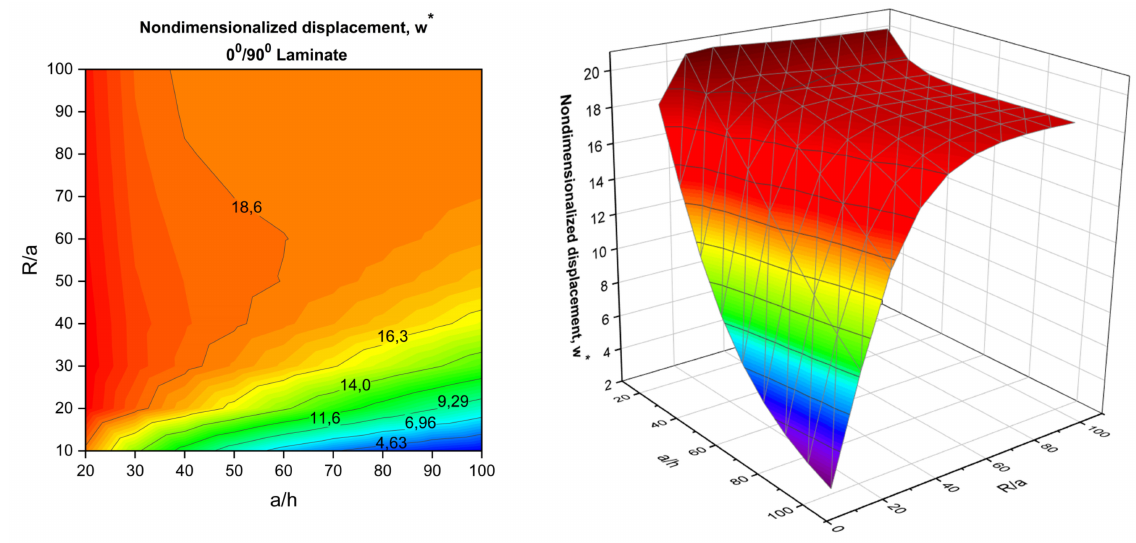
Figure 7. Nondimensionaldisplacement, w *,of(0 ◦ /90 ◦ )sphericalpanelswiththechangeofR/ a and a / h